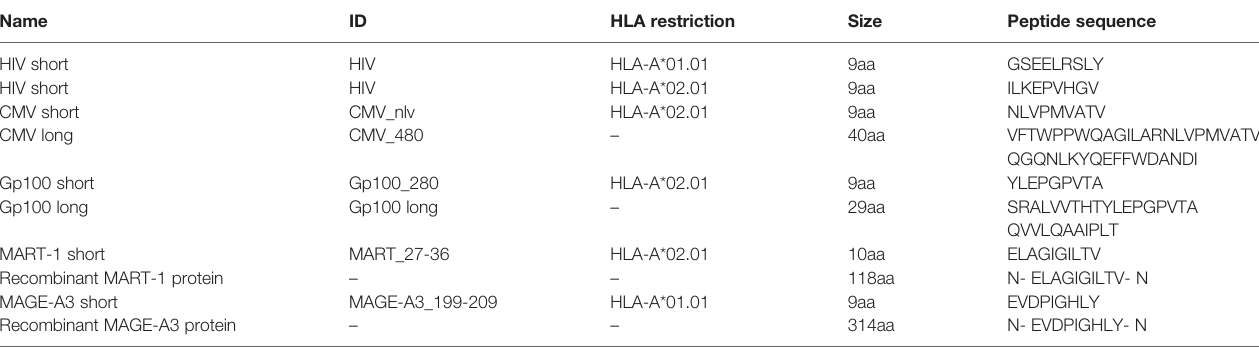
TABLE 2 | List of short peptides, long peptides and proteins used in this study. Name